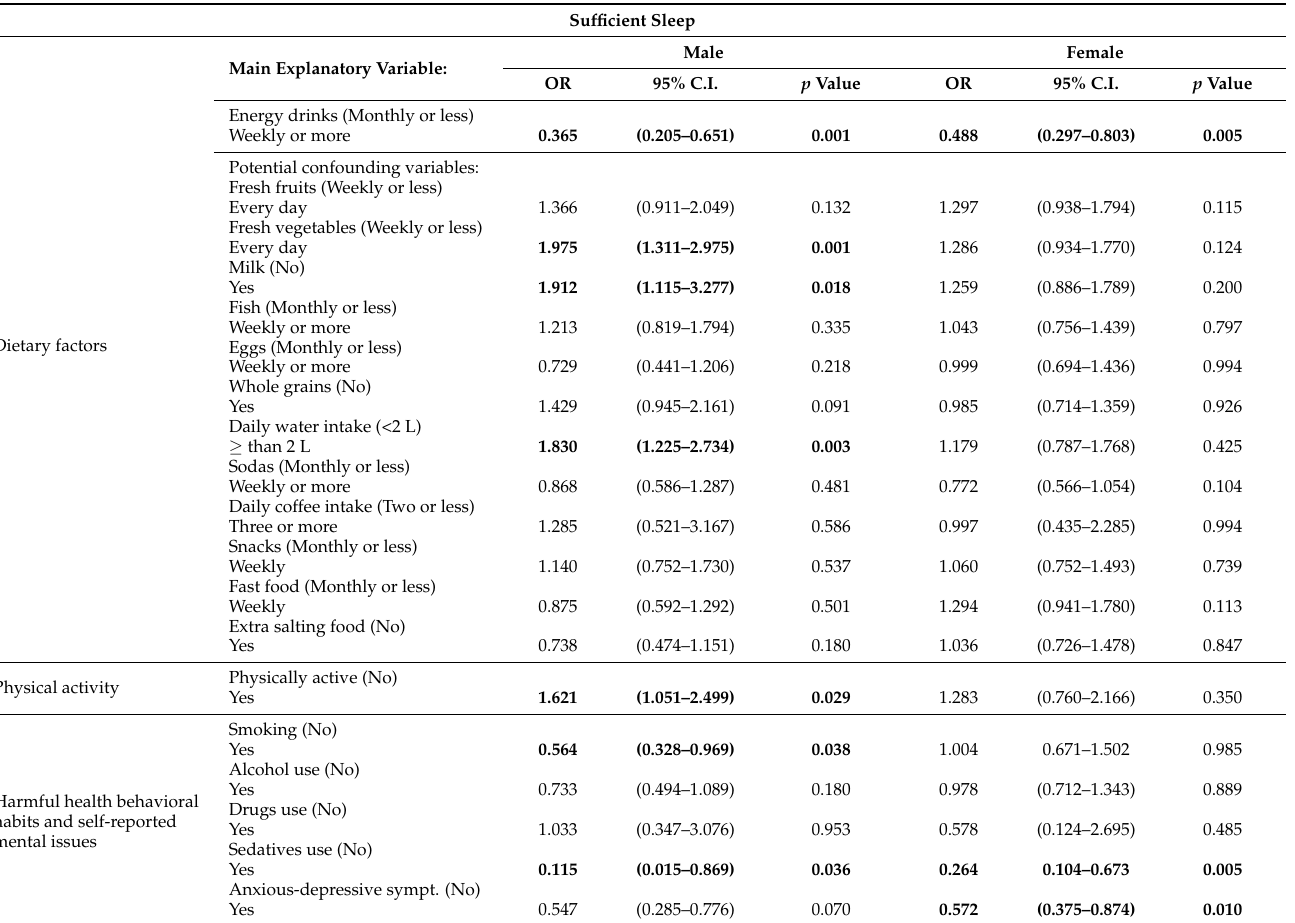
Table 2. The univariate logistic regression stratified by gender: personal factors and sleep sufficiency among adolescents ( n =